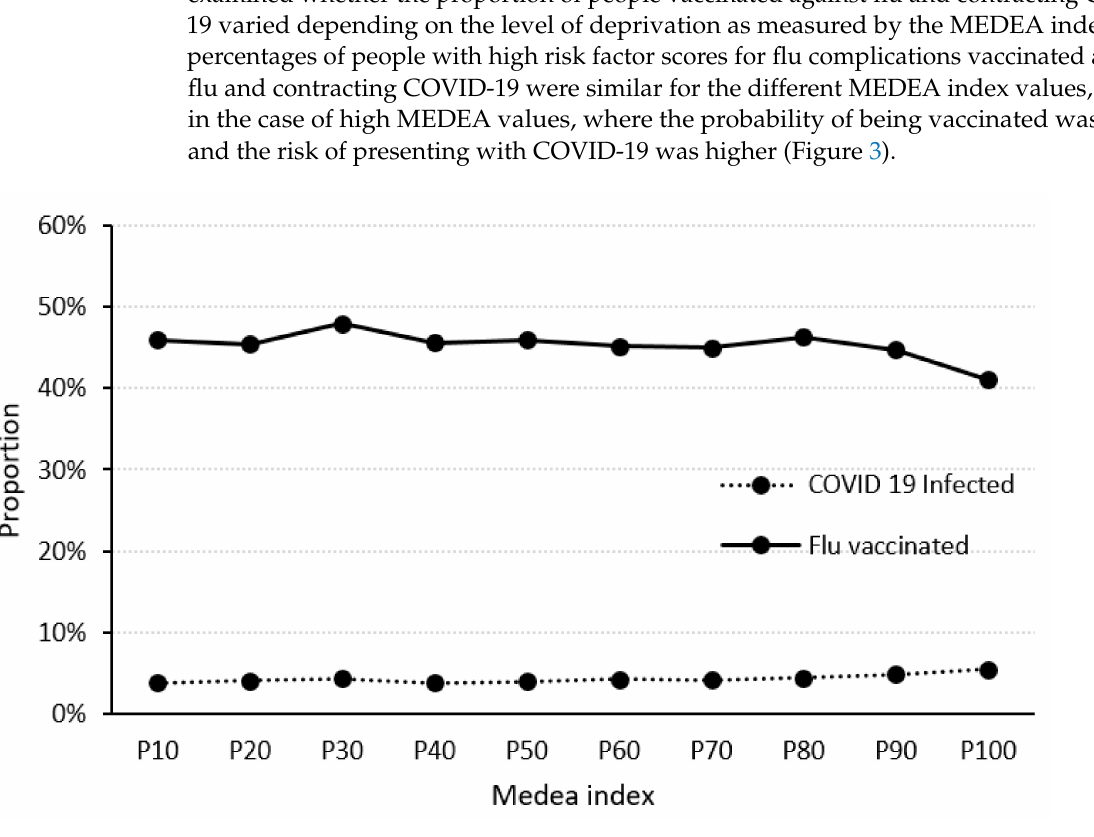
Figure 3. Relationship between the p of people vaccinated against flu and presenting with COVID-19, and the MEDEA